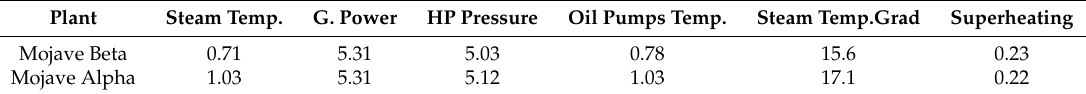
Table 4. Mean absolute error between the model output and the real data (in percentage). Plant Steam